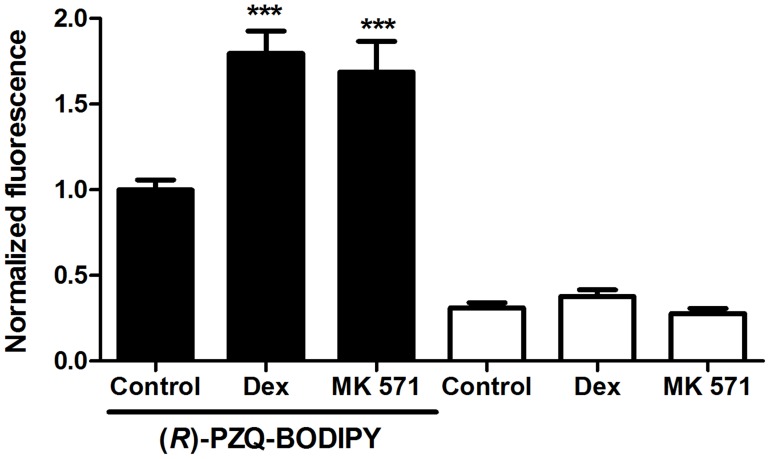
Dexverapamil and MK 571 significantly increase measured fluorescence intensity in adult male worms exposed to (R)-PZQ-BODIPY.Schistosomes were exposed to 1 µM (R)-PZQ-BODIPY in the presence or absence of 10 µM dexverapamil or 10 µM MK 571, as described, and Image J was used to measure fluorescence intensity from images taken at identical magnification and exposure levels. Intensity measurements on all worms were from an identically-sized rectangular area in an equivalent region of the worm slightly below the oral sucker. Intensity values were normalized to the (R)-PZQ-BODIPY samples. Data are from measurements of several worms spanning two independent experiments. Black bars represent worms incubated in (R)-PZQ-BODIPY, with added dexverapamil (Dex; n = 10), MK 571 (n = 10), or DMSO carrier (Control; n = 11); white bars represent worms incubated without (R)-PZQ-BODIPY, but with dexverapamil (Dex; n = 7), MK 571 (n = 7), or DMSO carrier (Control; n = 11). *** indicates P<0.001 compared to (R)-PZQ-BODIPY Control, ANOVA with Dunnett's Multiple Comparison post test.